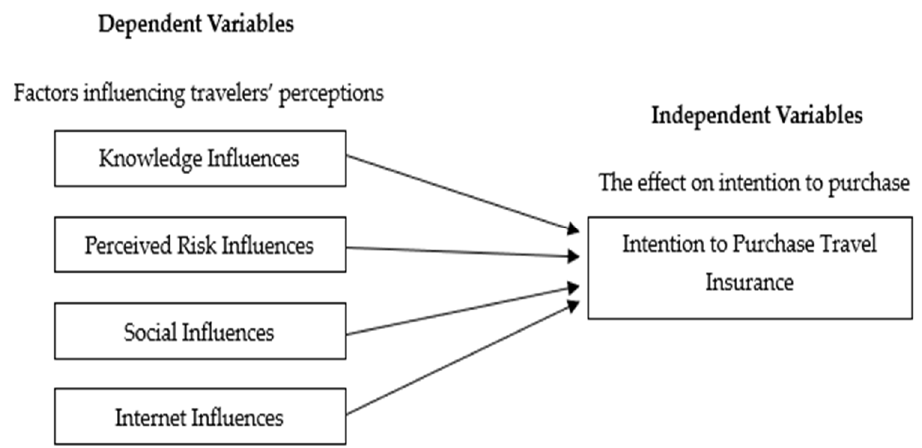
Figure 1. Research framework.